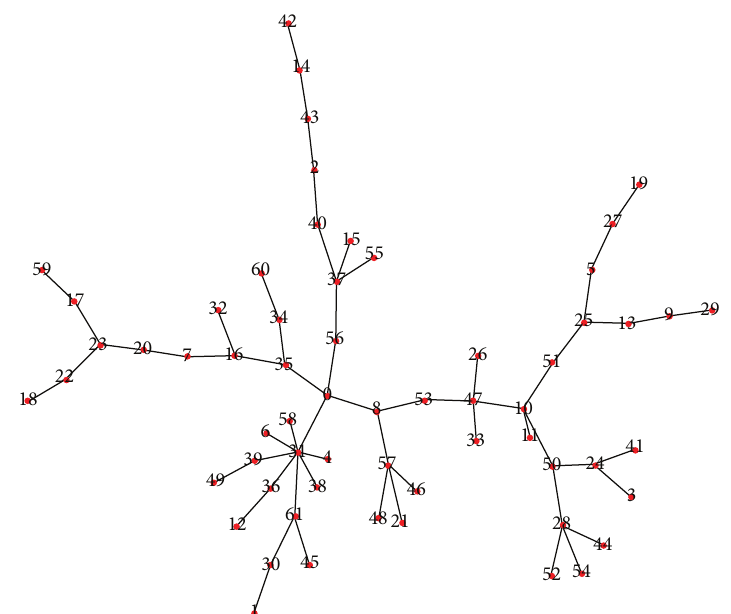
Figure 5: Energy stock jump complex network from October 2017 to April